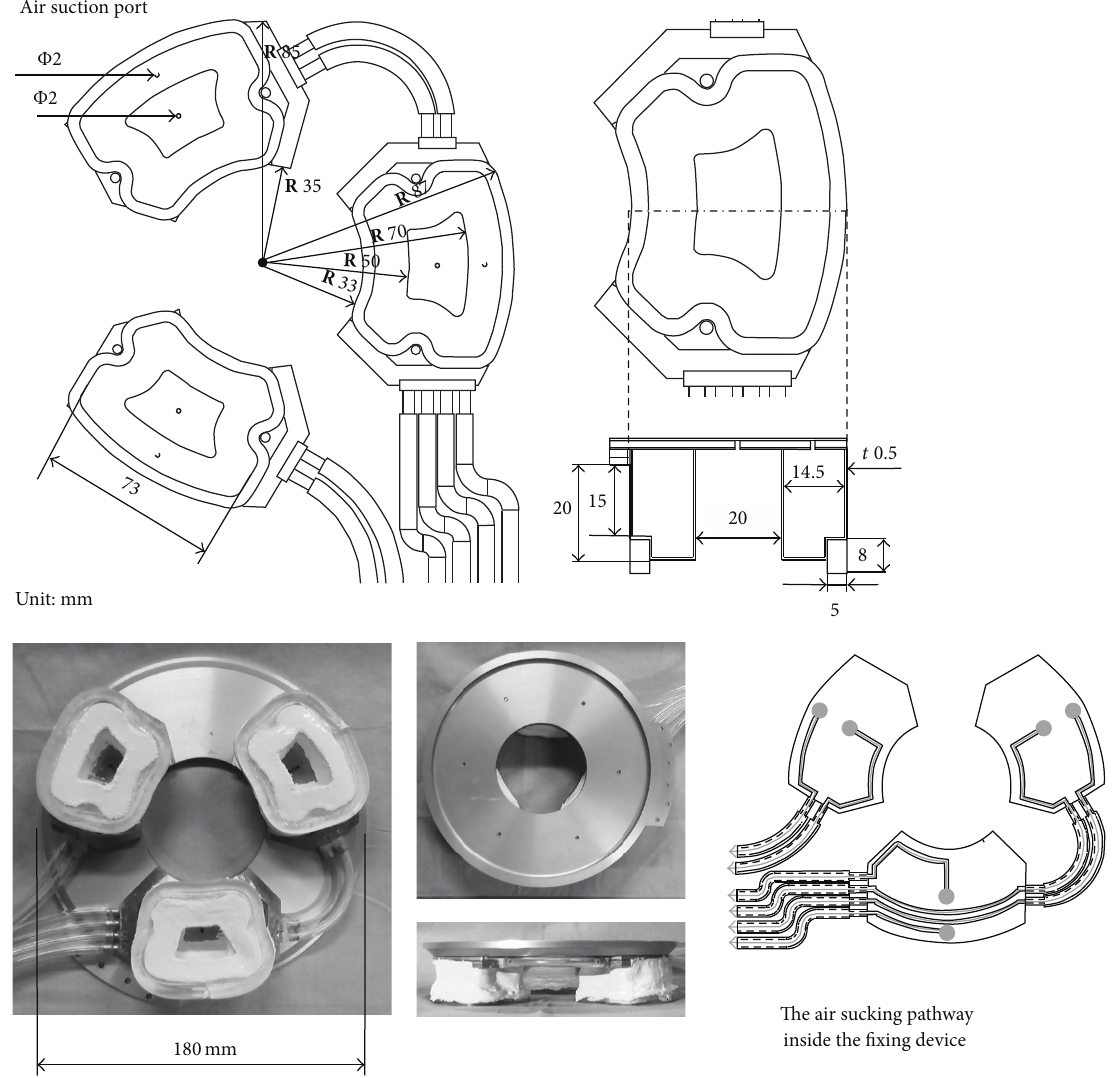
Figure 9: Jamming holding device and pathway of the air flow for the suction